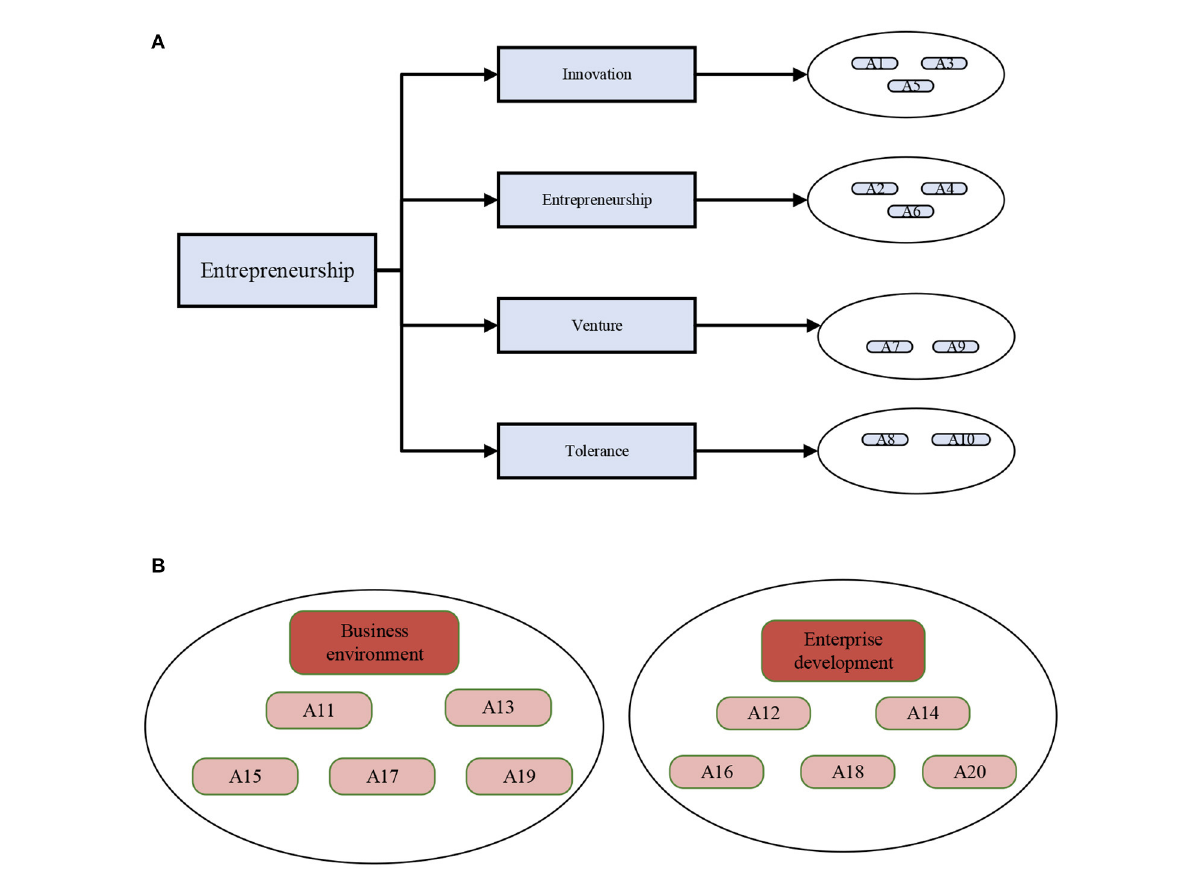
FIGURE4 Distribution map of items in the research scale (A) Distribution map of ES Scale; (B) Distribution of CLR-based business environment optimization Scale and ED